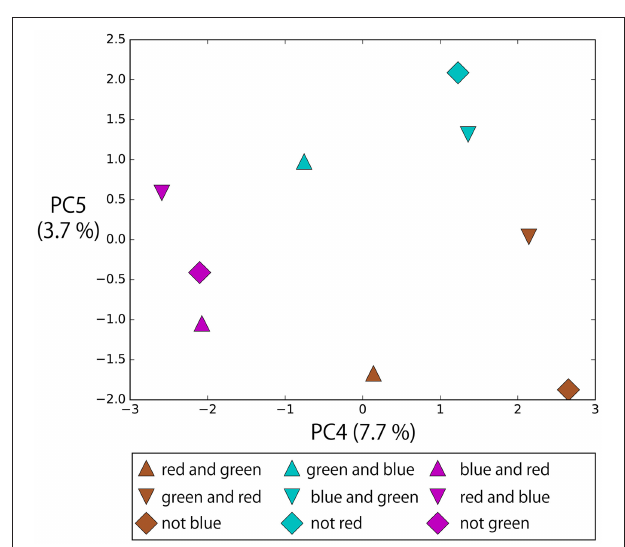
FIGURE 15 | The memory cell states after giving instructions in the form of “hit (objective part) slowly,” in which objective part is AND-concatenated or NOT-prefixed. The bell arrangement was fixed in the order of R, G, B from left to right. In this task, “not” indicates the complementary set. Therefore, for example, “not green” and “red and blue” have the same meaning. Although the objective parts of these instructions are completely orthogonal, they are located close each other in the space spanned by PC4 and PC5 and, as a result, instructions with the same meaning form clusters: R-AND-G, G-AND-B, and